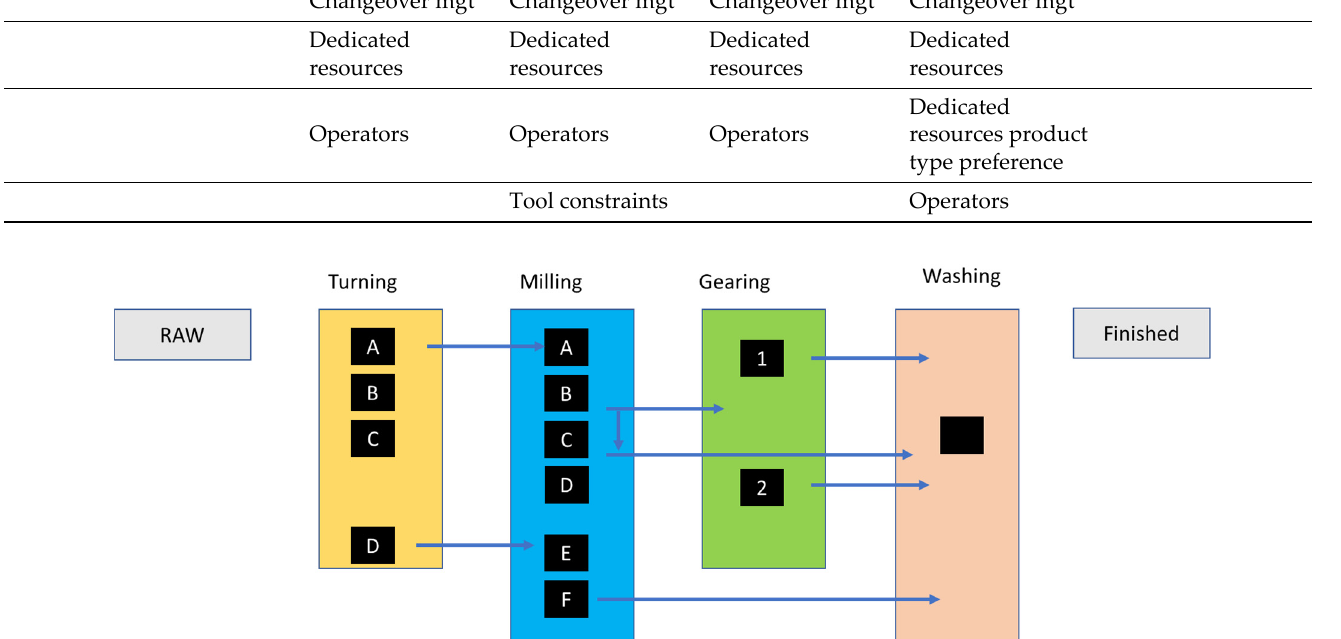
Figure 13. Process of work order flow.